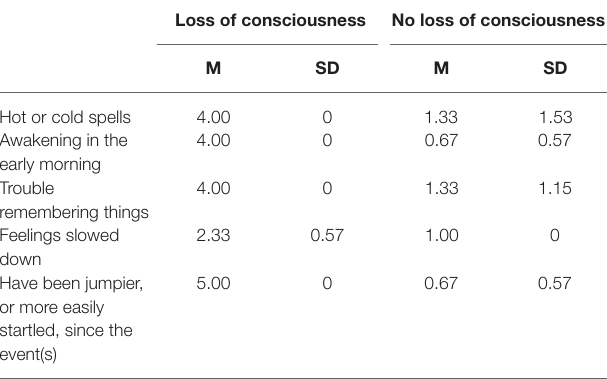
TABLE 2 | Mean and Standard Deviation of trending symptoms for women who lost consciousness and not lost consciousness survivors of intimate partner